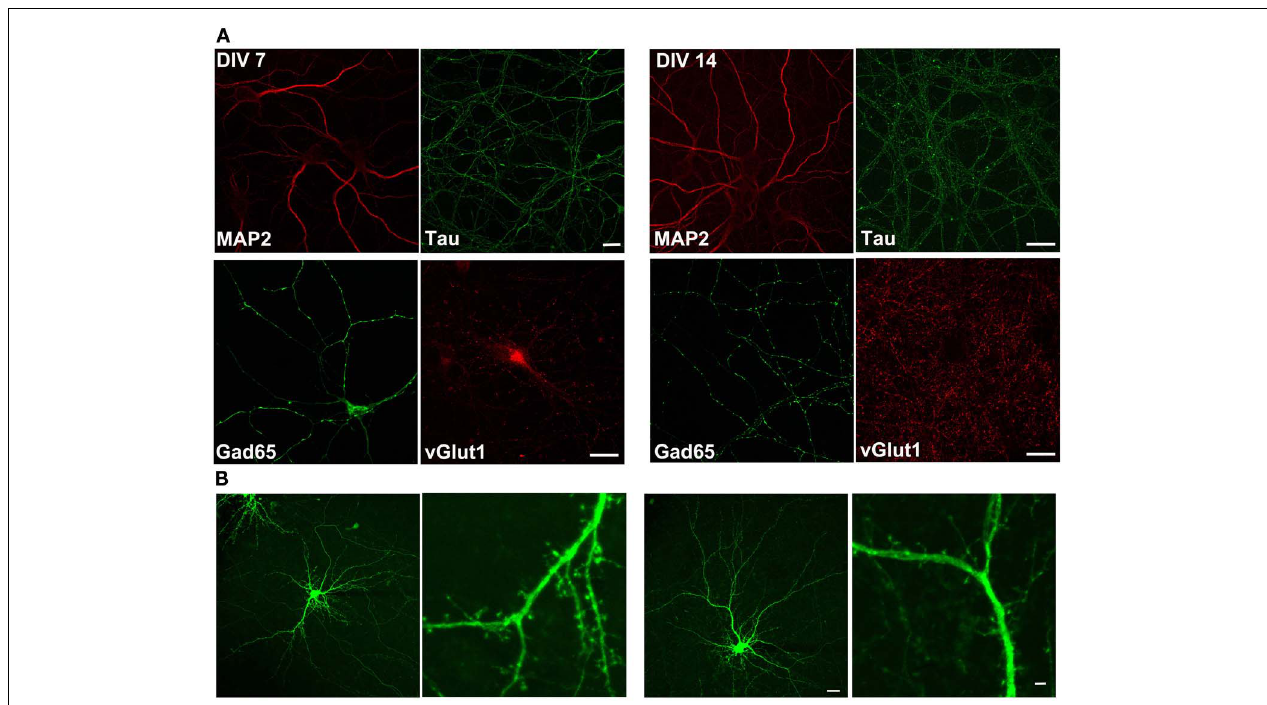
FIGURE 1 | Neurons cultured on silicon chip retain morphology and express neuronal and synaptic markers. (A) Confocal images of cortical neurons grown on polished silicon chip and immunostained with dendritic (Map2), axonal (Tau) and synaptic (Gad65 and vGlut1) markers at DIV 7 and